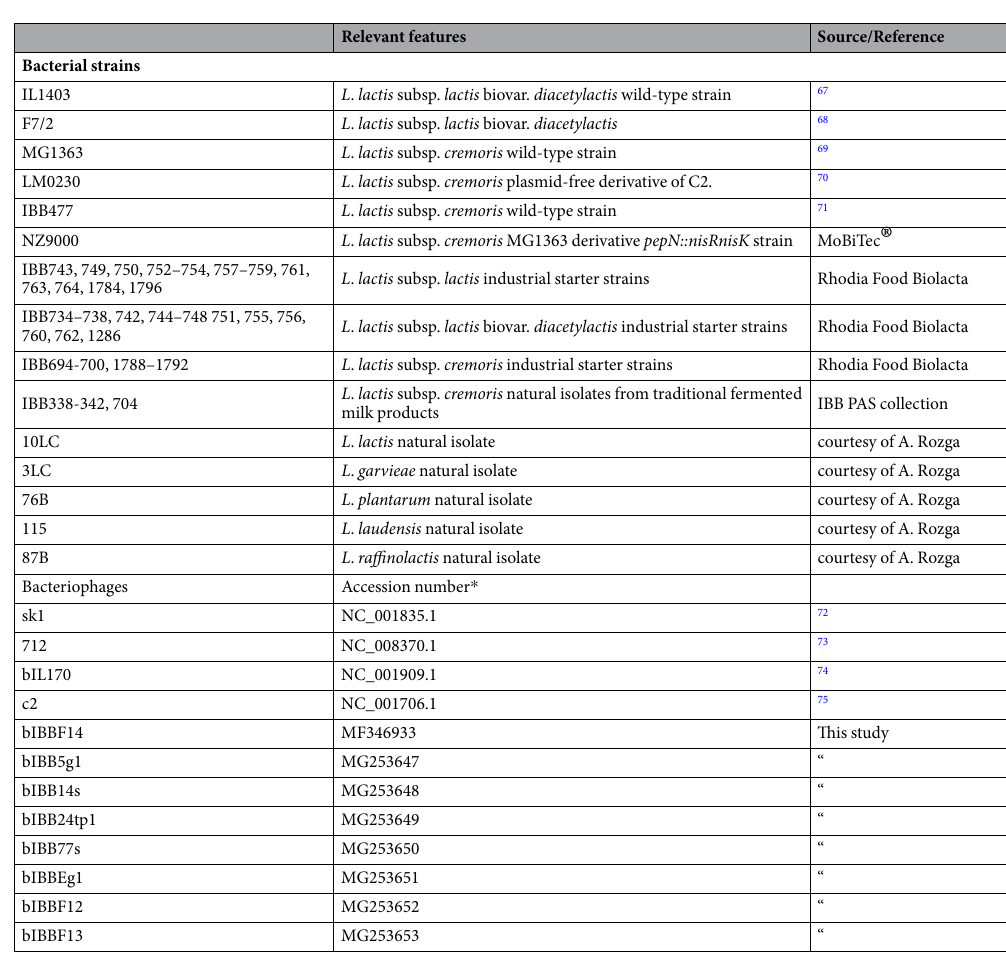
Table 1. Bacterial strains and phages used in study. * Complete genomic sequences of Lactococcus phages analyzed in this study were deposited in GenBank under the given accession